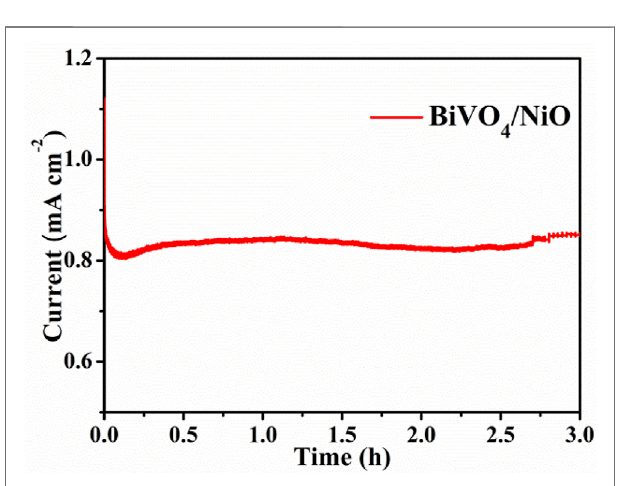
FIGURE 7 | Stability curves of NiO/BiVO 4 photoanode under the same conditions. injection ef fi ciencies were tested in Figures 4B,C . Charge separation ef fi ciency is an important parameter to evaluate the proportion of carriers reaching the electrode surface/electrolyte interface to participate in water oxidation (Wang et al., 2017b).